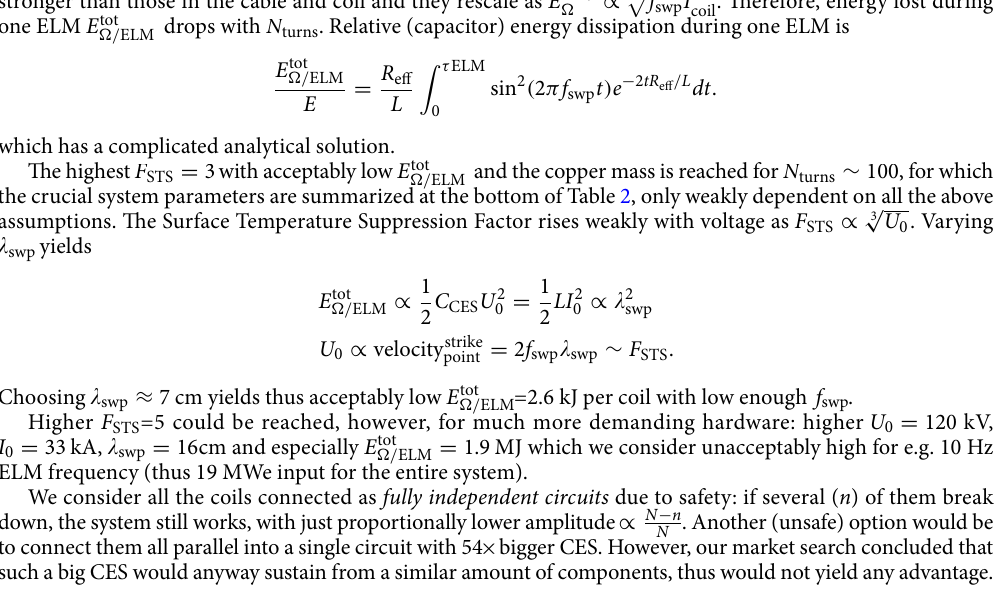
Figure 5. The overall desired strike point shift (cid:31) swp for 10 kA simulated for the most heat loaded (outer) target. Eddy currents in the divertor structure and AMC generate (undesirably) a frequency low-pass filter. Similarly, the effect of slowly flying ions further weakly decreases. The yellow fit is further used in Fig. 6 and Table